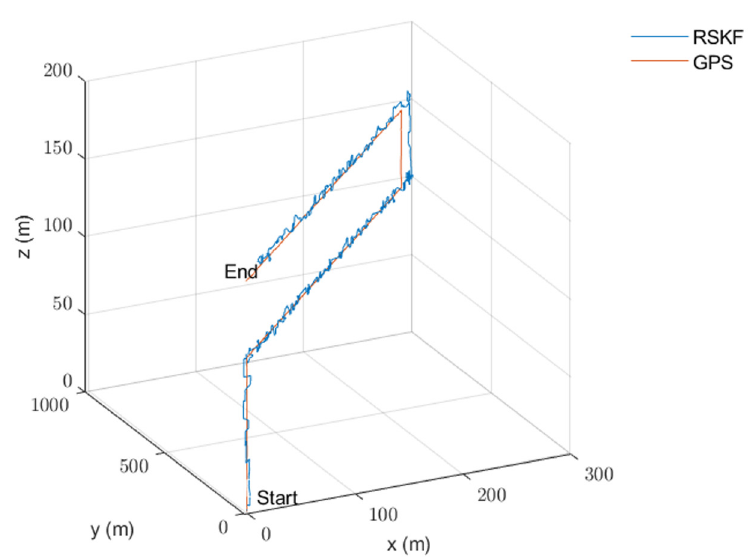
Sensors 2023 , 23 , x FOR PEER REVIEW